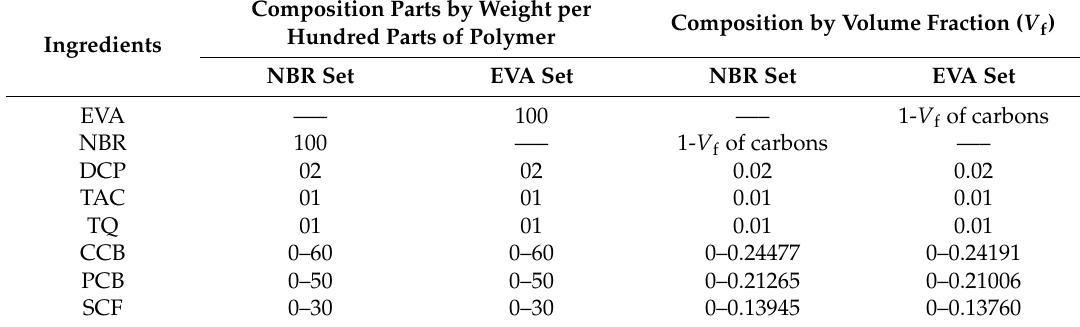
Table 1. Formulations of ethylene vinyl acetate (EVA) and acrylonitrile butadiene rubber (NBR)